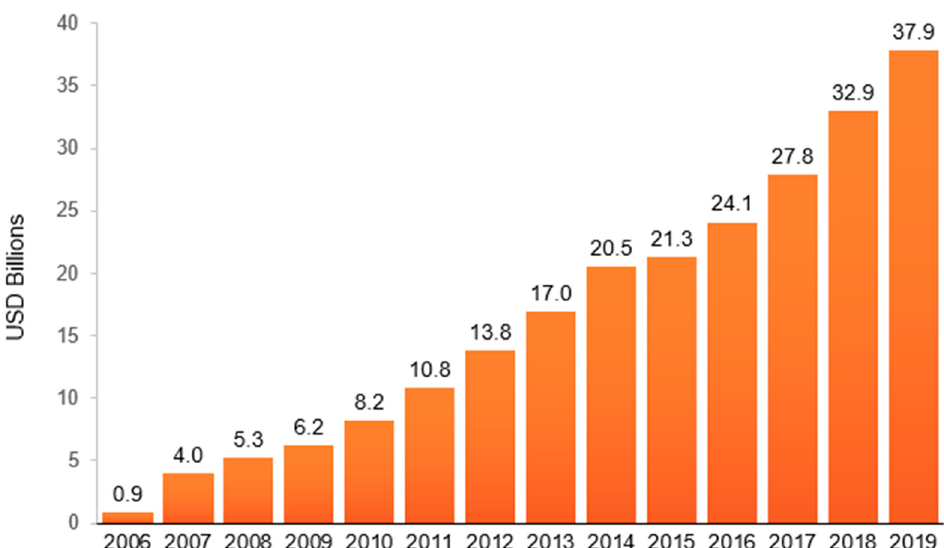
Figure 1. Retail value* of packaged junk foods and soft drinks** in India from 2006–2019 (In USD billions; Rupee and Dollar values in terms of Indian Consumer price index 2006 = 1.00). *Retail selling price, i.e., sales at end-price to consumers, including retailer and wholesaler mark-ups and sales tax (except in the US and Canada) and excise taxes. **Junk food and soft drink categories include: cakes, pastries, confectionery (chocolate, sugar confectioneries, and gum), savory snacks (nuts, seeds, trail mixes, salty snacks, savory biscuits, popcorn, pretzels, and other savory snacks), instant noodles, sweet snacks (fruit snacks, snack bars, sweet biscuits, and ice cream), carbonates, concentrates, juice drinks, and nectars (excluding 100% juices), ready-to-drink coffees and teas, energy drinks, and sports drinks. Data source; Euromonitor International Limited 2021 © All rights reserved.